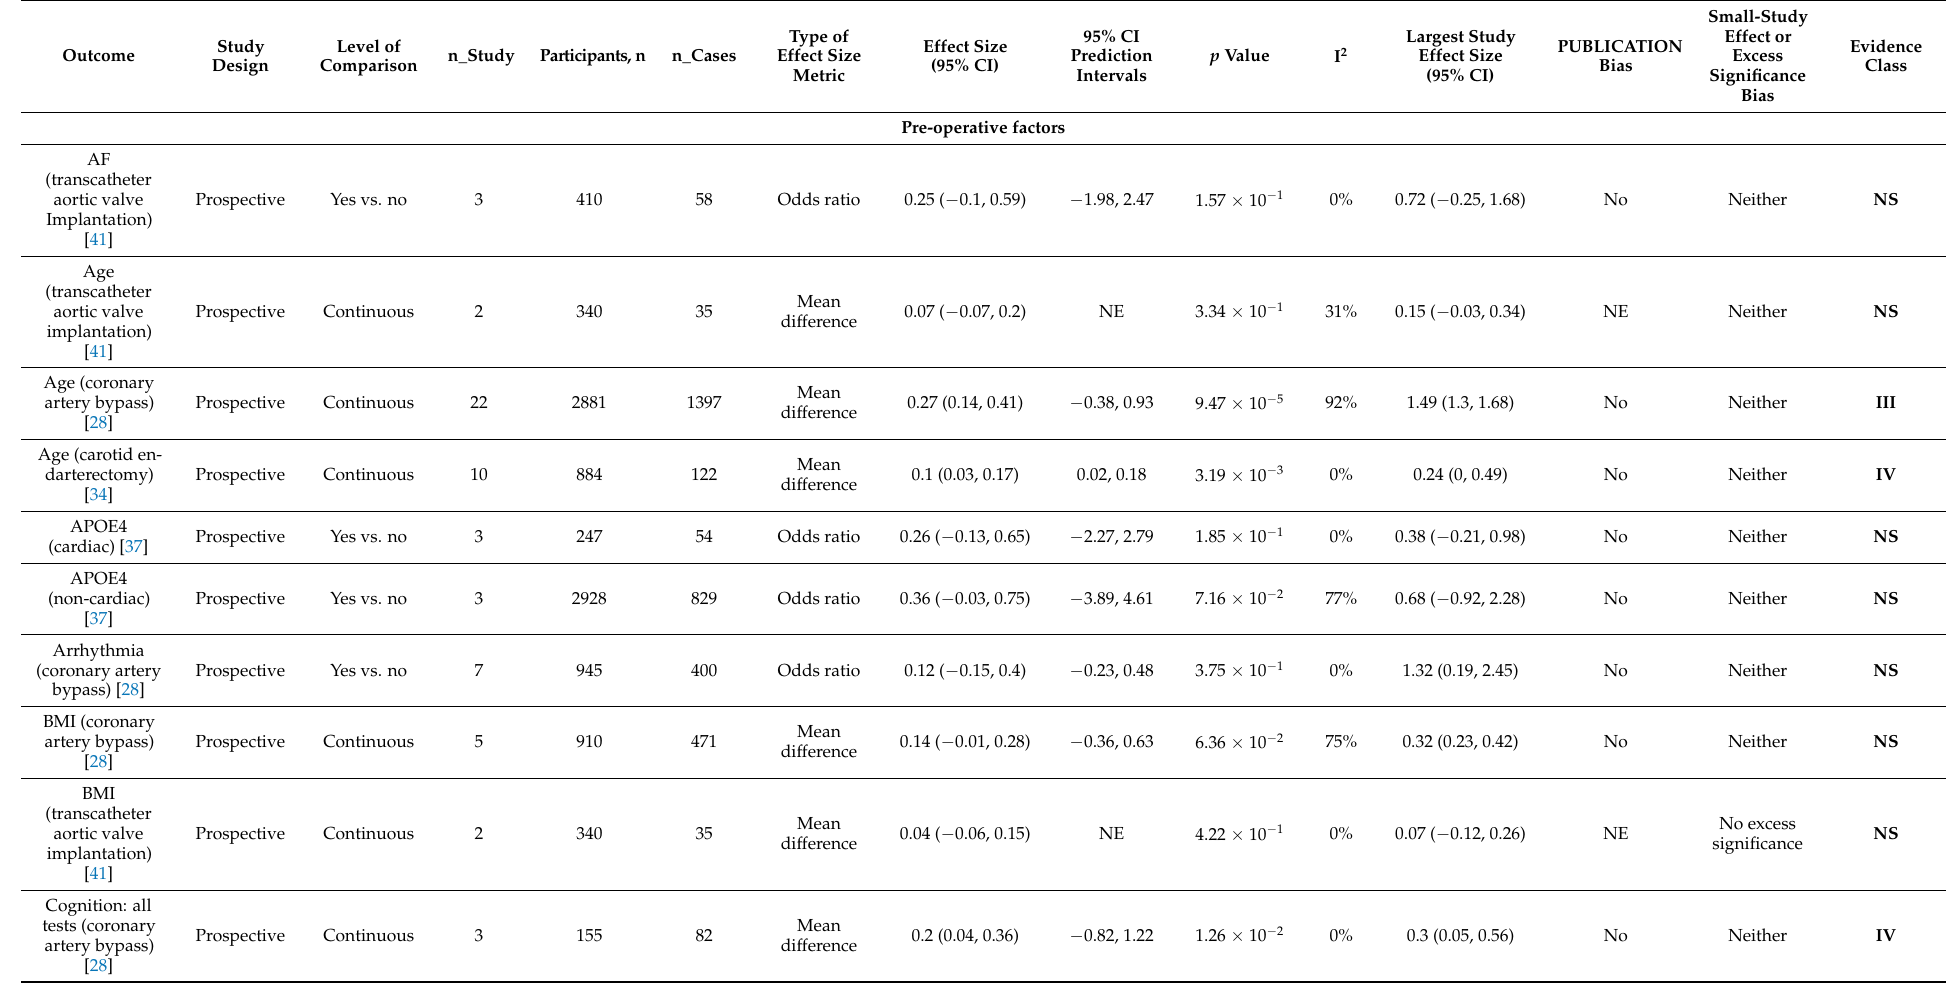
Table 1. Summary of included risk factors and their associations with post-operative cognitive